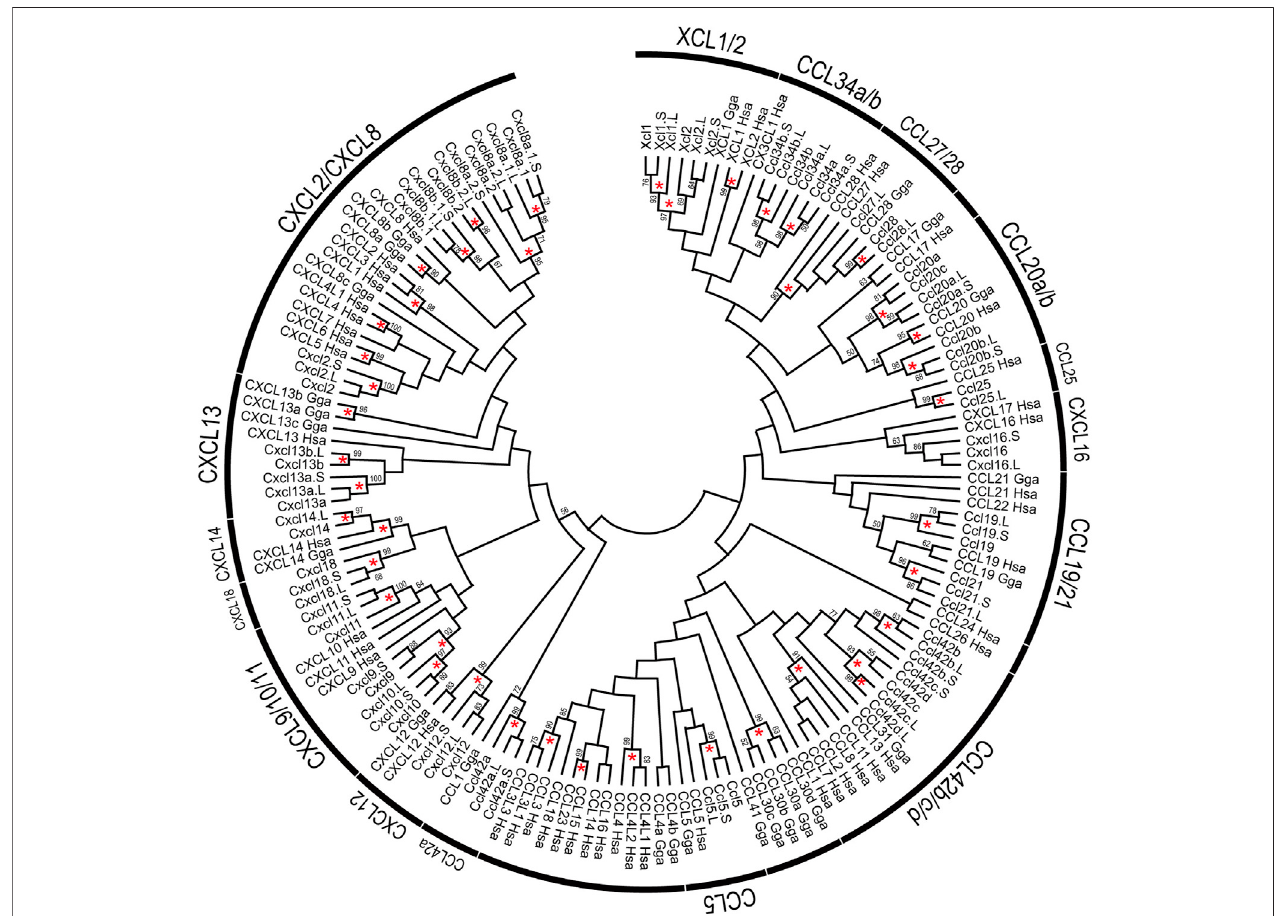
FIGURE3| Phylogenetic treeofchemokineligands.Thetreeindicates154chemokineproteins, including52of X.laevis ,30of X.tropicalis ,24of G.Gallus ,and48 of H. sapiens genes. Chemokine names related to Xenopus represented on the arcs. Bootstrap values greater than 50% were indicated, and asterisks show values greater than 90%. The alignment of chemokine proteins was prepared using CLUSTAL omega. Maximum likelihood methods using full-length were performed with 1,000 bootstraps using JTT with Gamma-distributed model, and inference option was a nearest-neighbor interchange method on NJ tree.